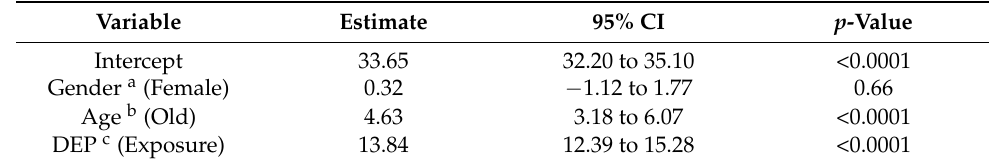
Table 4. Multiple linear regression results on outcome variable DNA damage (OTM